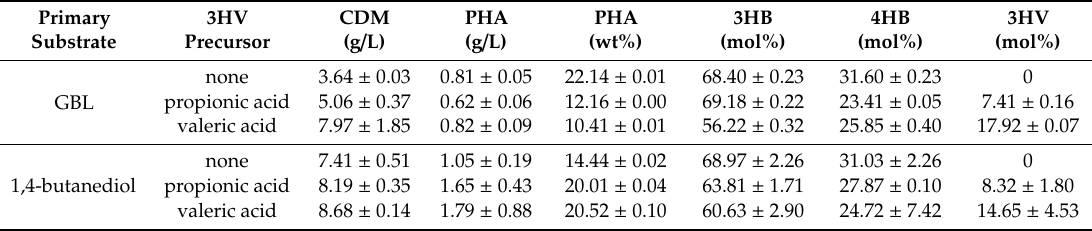
Table 2. Single stage terpolymer production (72 h cultivation, application of 3HV precursor at the 24 h of cultivation 1 g /